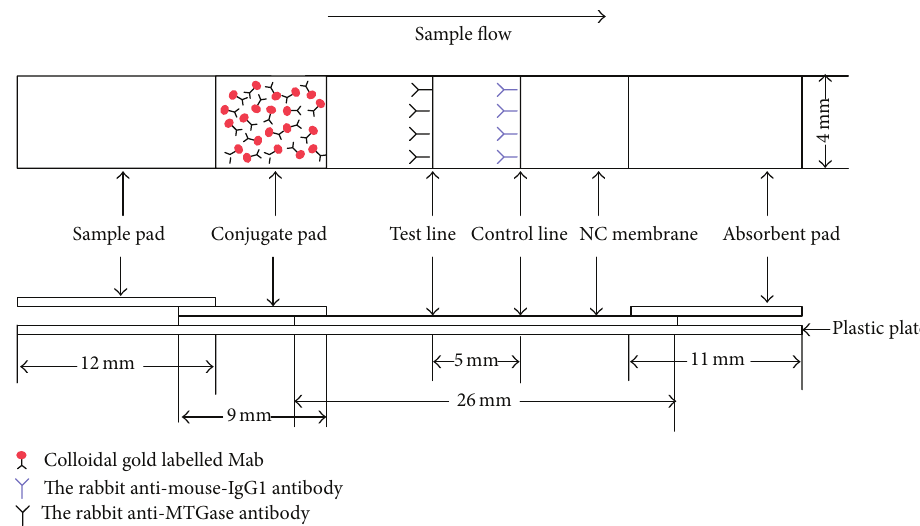
Figure 1: Description of the immunochromatographic